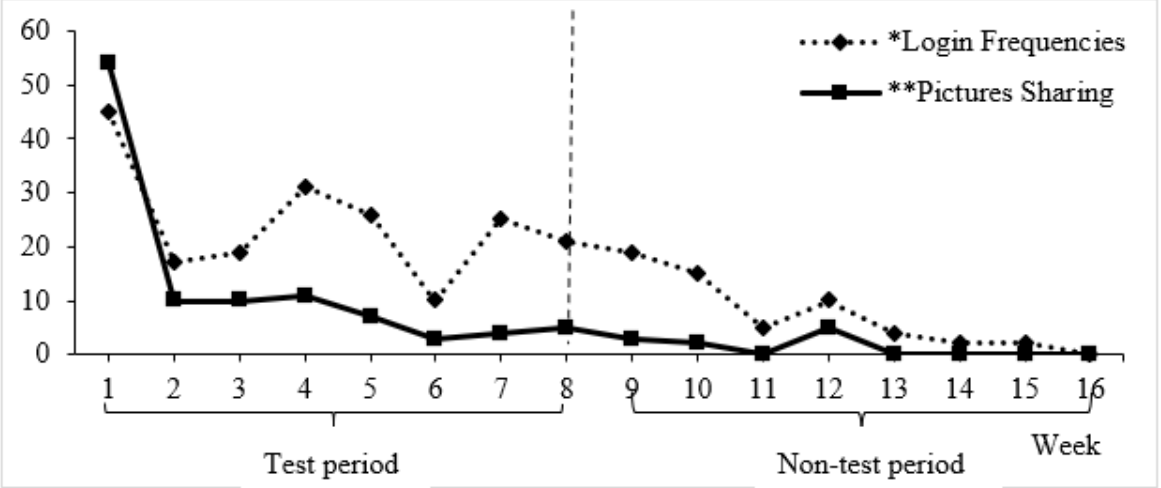
Figure 2. Frequency of logins to the app and sharing of paintings during and after the 8-week intervention.